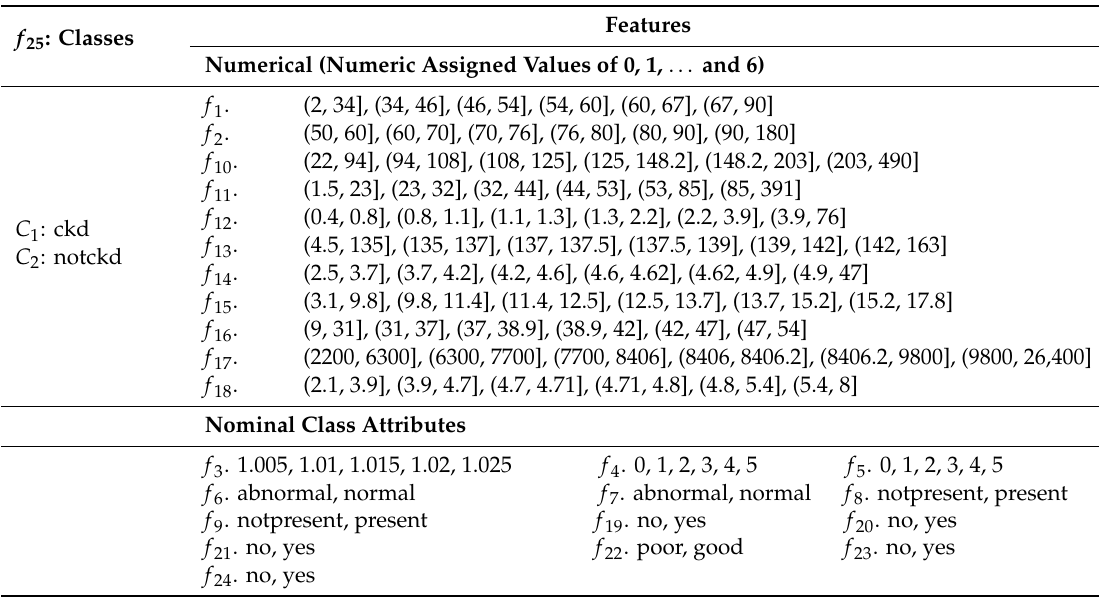
Table 1. The chronic kidney disease dataset used in the experiments [47].